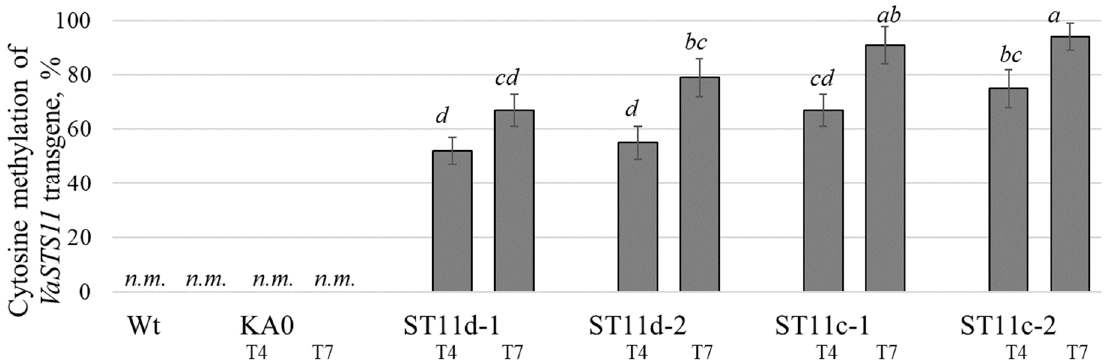
Figure 3. Cytosine methylation level (%) within the selected part of the protein coding regions of the VaSTS11d and VaSTS11c genes. Wt—wild-type A. thaliana plants; KA0—the control KA0 A. thaliana plants transformed with the vector harboring only the npt II selective marker; ST11d-1, ST11d-2— A. thaliana plants transformed with the VaSTS11d gene; ST11c-1, ST11c-2— A. thaliana plants